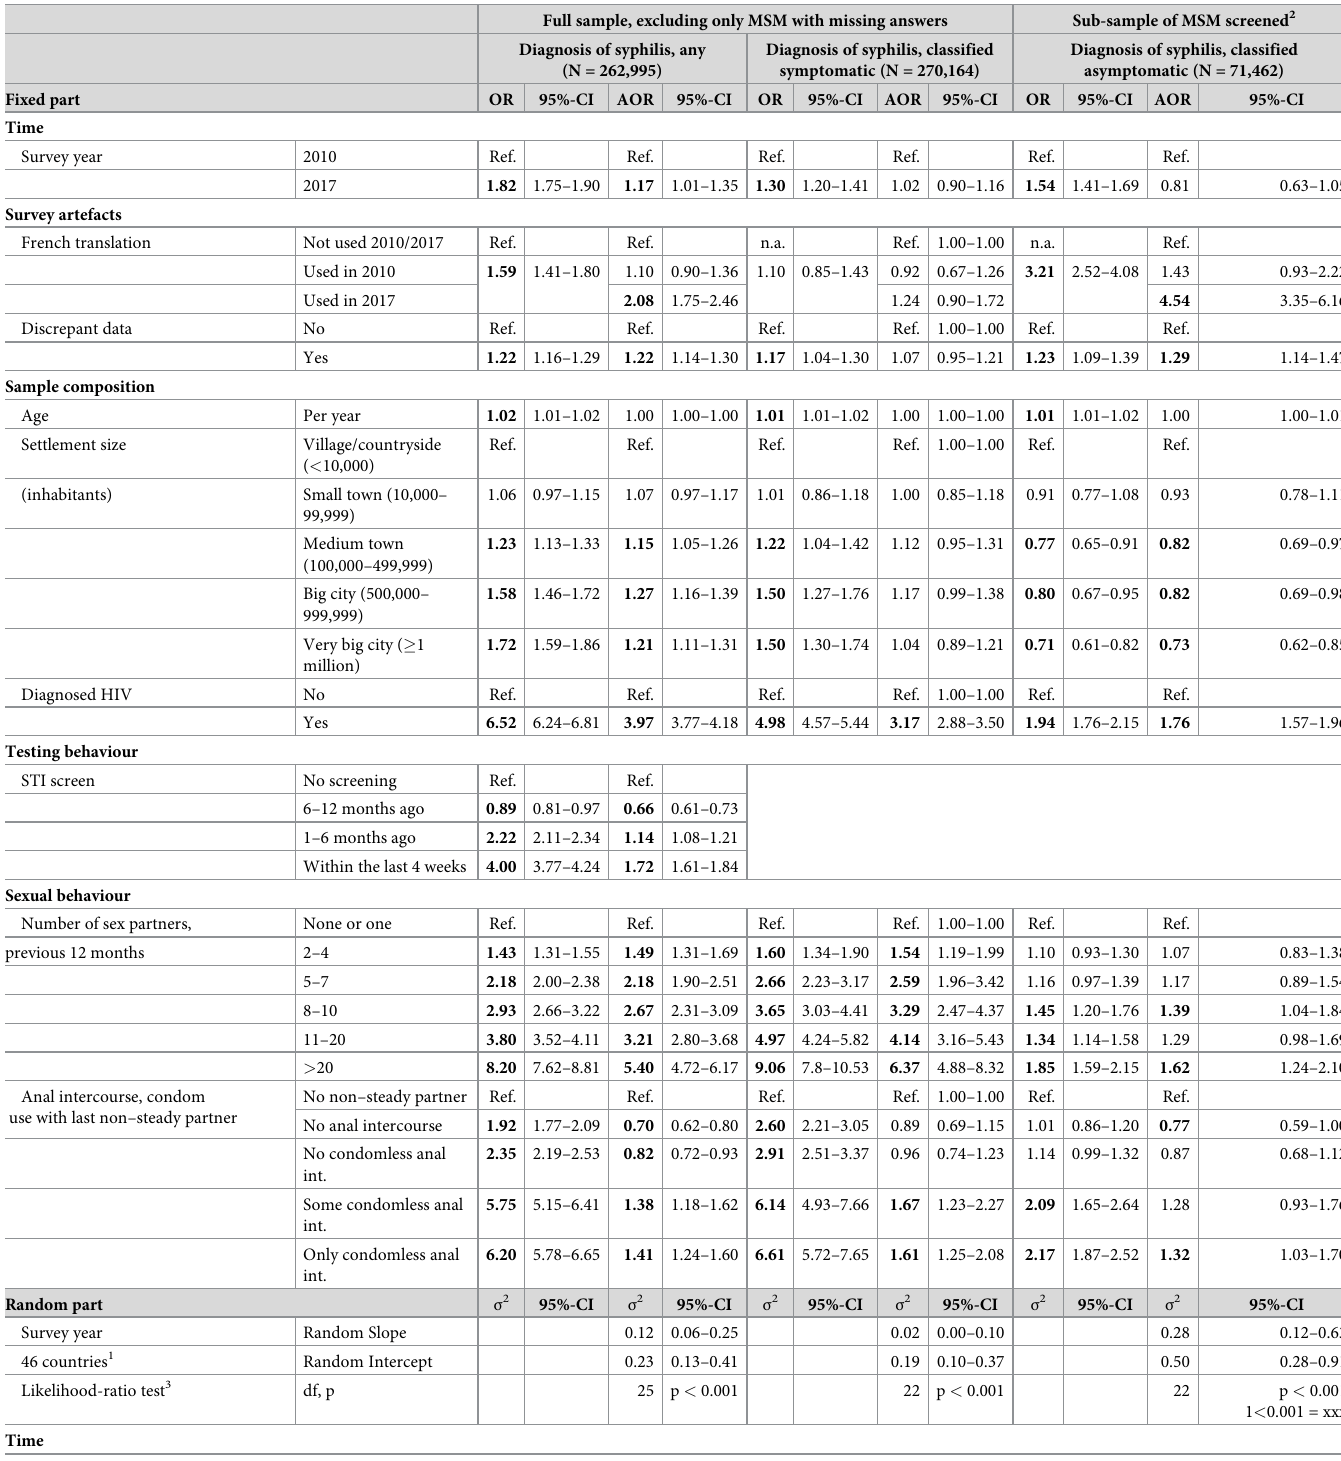
Table 1. a. Univariable and multivariable regression analysis, main model: Individual-level associations with syphilis diagnosis. b. Univariable and multivariable regression analysis, comprehensive model: Individual-level associations with syphilis diagnosis including impact of country-level 1 screening rates on syphilis diag- nosis (intervention